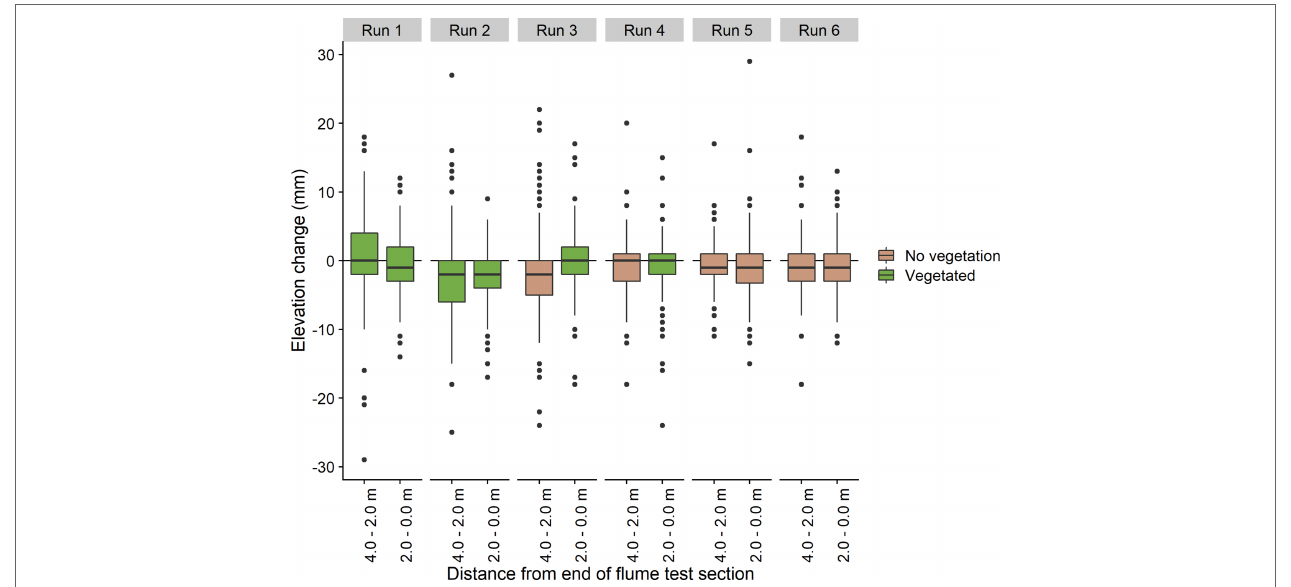
FIGURE 7 | Boxplots summarizing the sediment bed elevation changes as a result of the different experimental runs with outliers represented as black dots. The data were split between the first two meters of the test section (having a vegetation cover in runs 1-2, and no vegetation in runs 3-6) and the back-end two meters (with vegetation in runs 1-4, no vegetation in runs 5-6). Presence or absence of vegetation is indicated by green or brown colors,